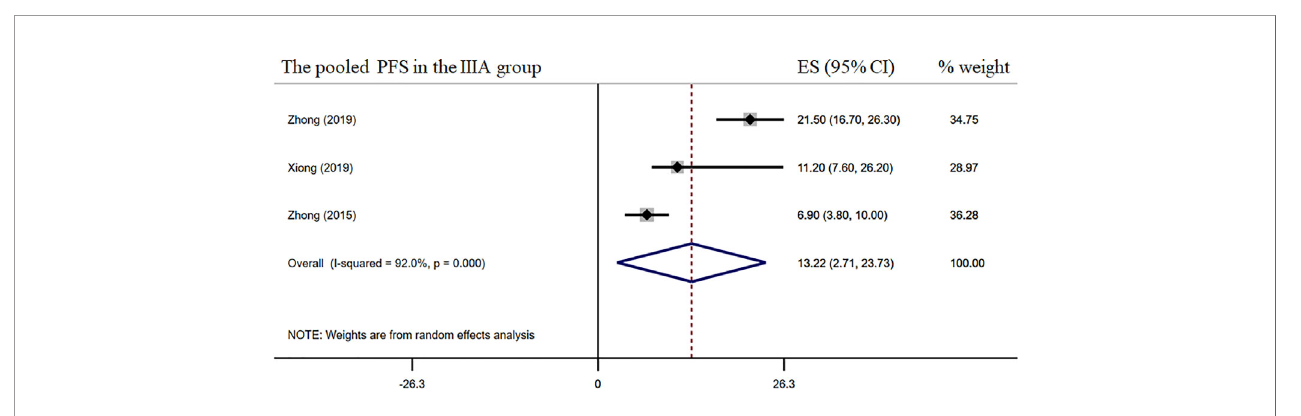
FIGURE 4 | Median PFS of the stage IIIA subgroup.